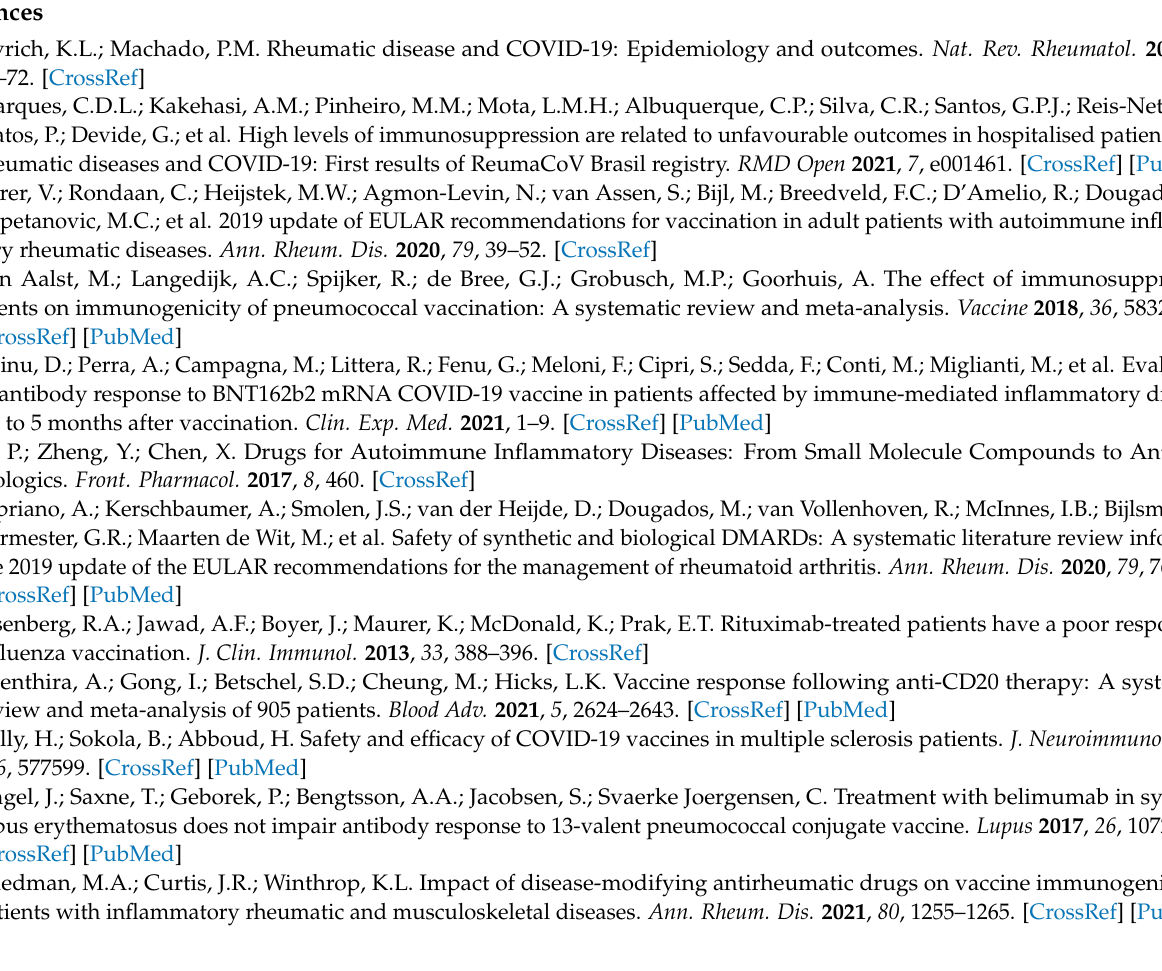
assessment of included case series using the Joanna Brigg’s Institute Critical Appraisal tool; Table S5: Quality assessment of included randomised-controlled trials using the Joanna Brigg’s Institute Crit- ical Appraisal tool; Figure S1: Trim-and-fill funnel plot with imputation of potentially missing studies; Figure S2: Linear regression test of funnel plot asymmetry; Figure S3: Leave-one-out analysis; Figure S4: Rate of seroconversion after administration of a booster dose in non-responders to a pri- mary series of COVID-19 vaccination using the fixed effects model; Figure S5: Rate of seroconversion after administration of a booster dose in non-responders to a primary series of COVID-19 vaccination using the random effects model with Hartung-Knapp adjustment; Figure S6: Identification and exclusion of